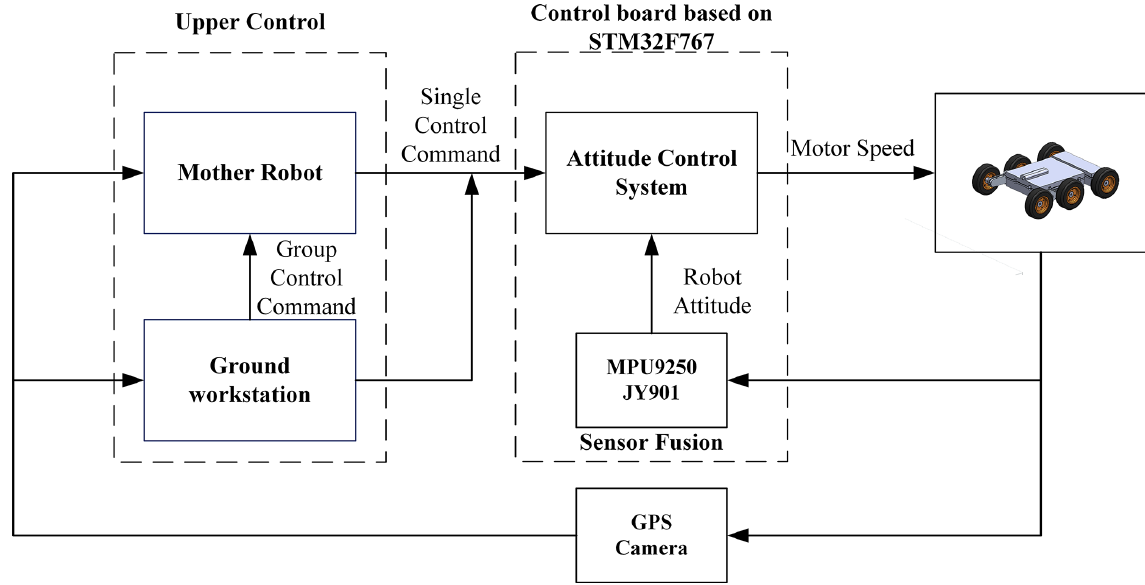
Figure 20. The structure of the robot’s control